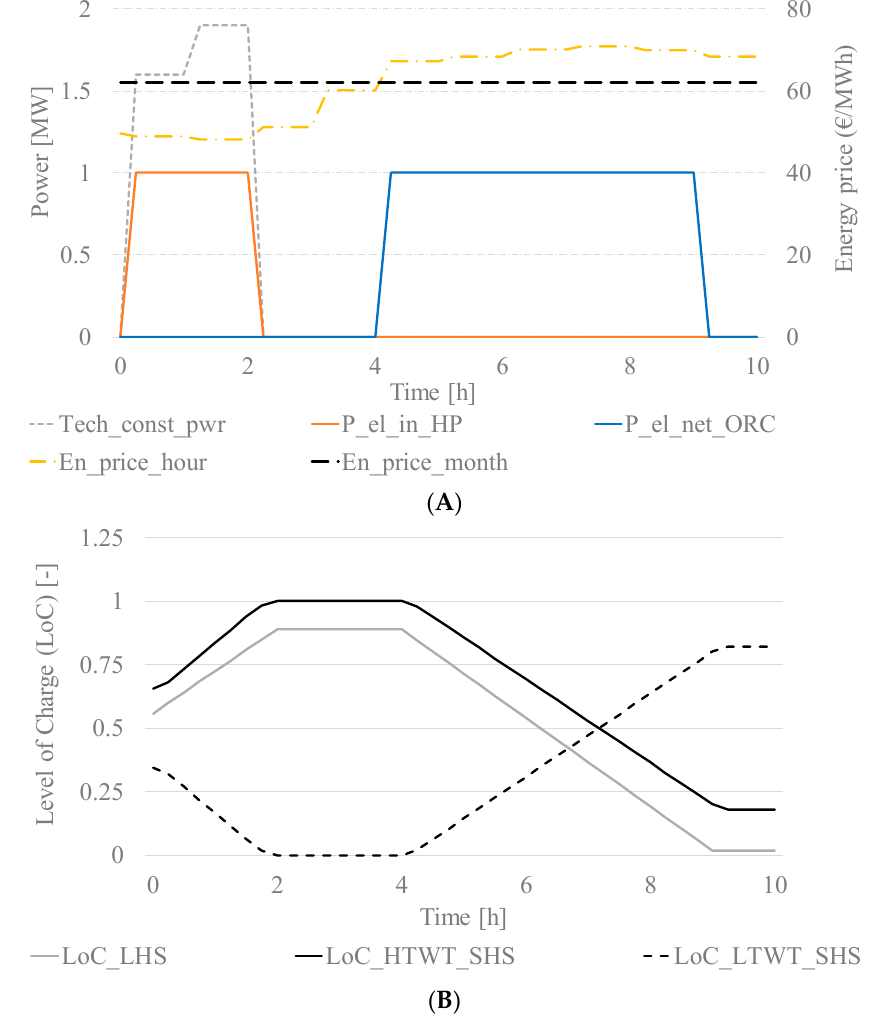
Figure 7. TRNSYS plot charts of the power and energy prices profiles ( A ) and level of charge of the thermal energy storage tanks ( B ) for the first week of simulation in case 1.A.